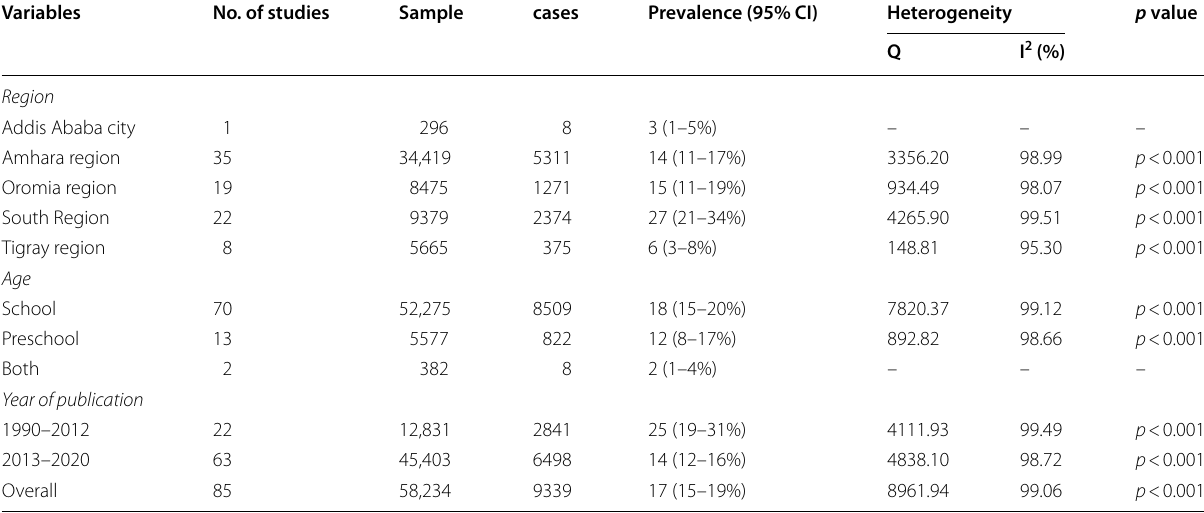
Table 4 Pooled prevalence of species specific Ascaris lumbricoides by region, age and year of publication among Ethiopian